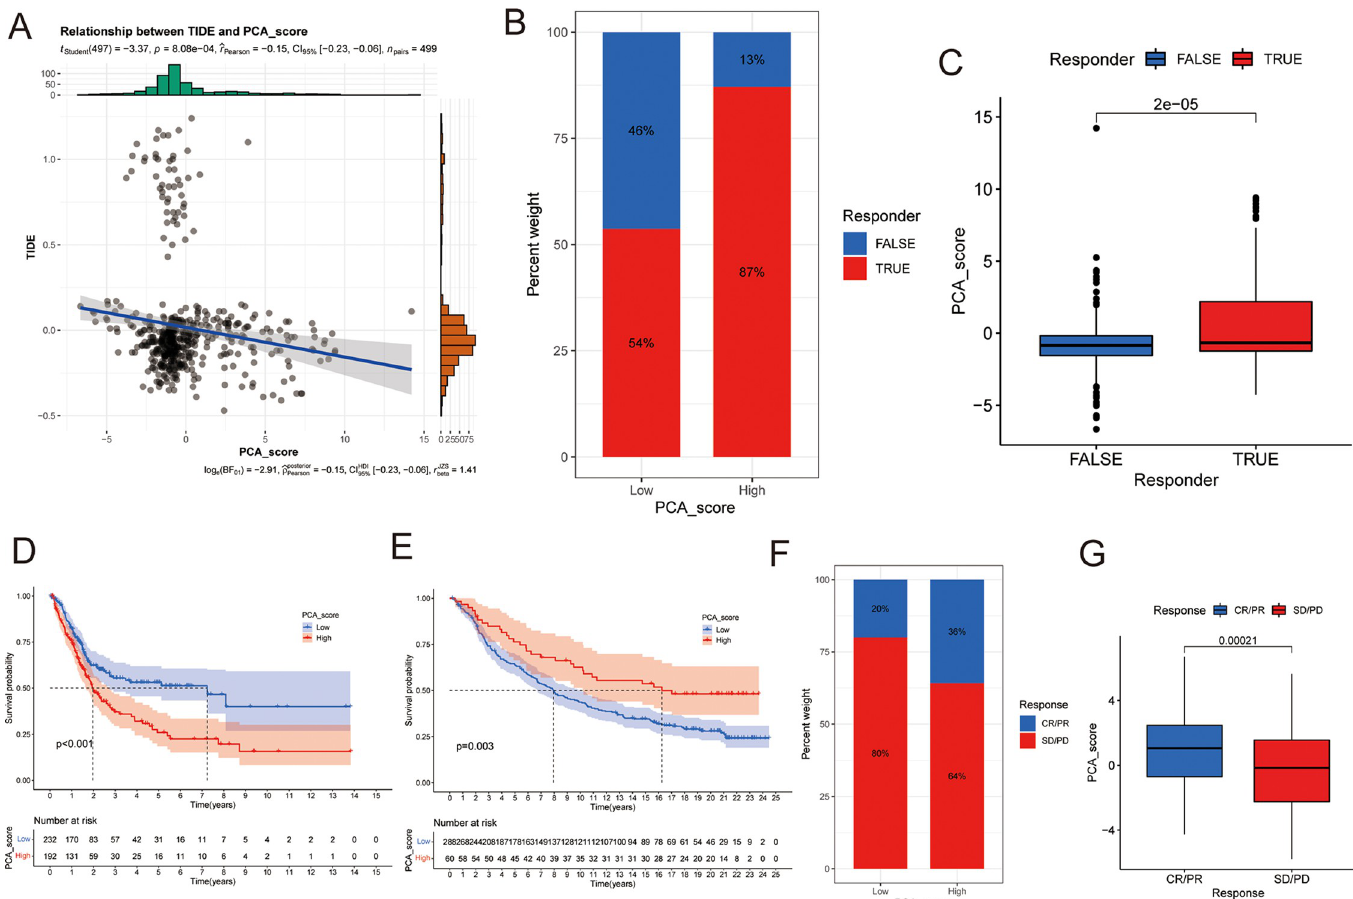
Fig 8. Comprehensive analysis of PCA_score with immunotherapy response in LGG patients. (A) Correlations between PCA_score and TIDE. (B) Proportion of LGG patients with H-PCA_score and L-PCA_score responding to immunotherapy. (C) Difference of PCA_score between “TURE” group and “FLASE” group. (D) Survival analyses for L-PCA_score and H-PCA_score patient in TCGA-BLCA cohort using Kaplan-Meier curves. (E) Survival analyses for L-PCA_score and H-PCA_score patient in IMvigor210 cohort using Kaplan-Meier curves. (F) The proportion of patients with response to PD-L1 blockade immunotherapy in L-PCA_score and H-PCA_score. (G) Distribution of PCA_score in distinct anti-PD-L1 clinical response